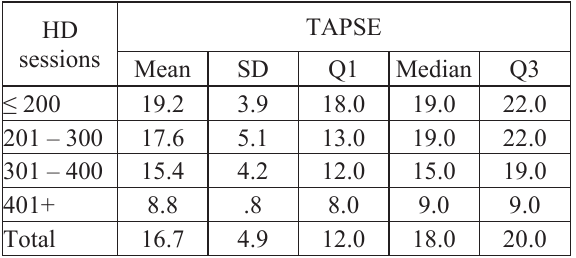
Table-4: TAPSE among 4 HD Session groups